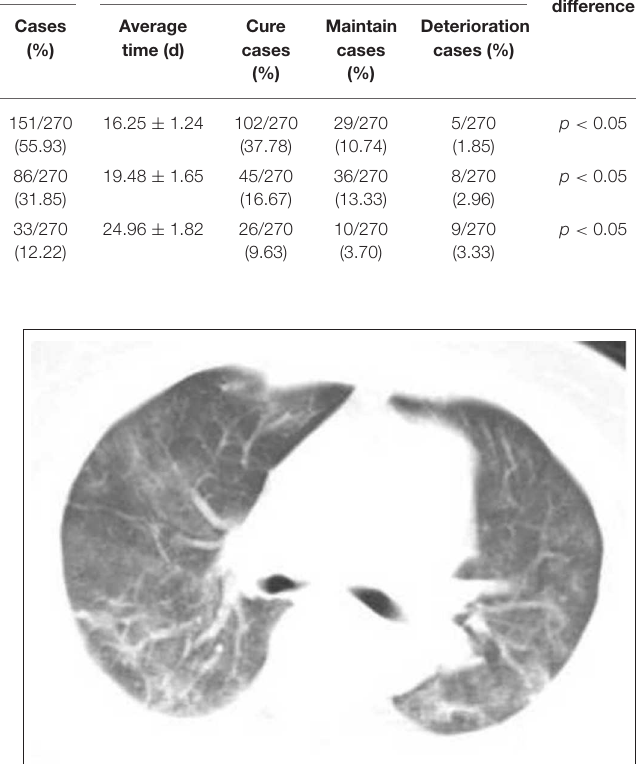
FIGURE 2 | Female, 56 years, with fever pending investigation. HRCT plain scan axial lung window showing lesions in bilateral lung lobes at the first time; This figure shows common type lesions.